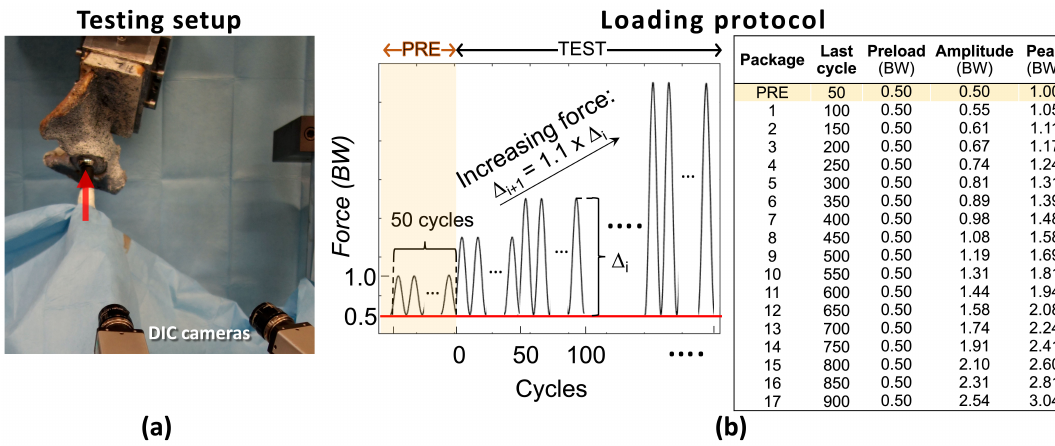
Figure 2. Test setup and loading protocol: ( a ) The specimen was aligned in the testing frame so as to apply a force (arrow) in a direction that replicated level walking. The cameras of the DIC system were placed so as to frame both the cup and the surrounding bone. ( b ) Load cycles of increasing magnitude were applied: each load packages consisted of 50 cycles; each package was 10% larger than the previous one; the force was scaled on the patient body weight (BW). The first load package (50 cycles 1.00 BW) was used for pre-conditioning before the actual